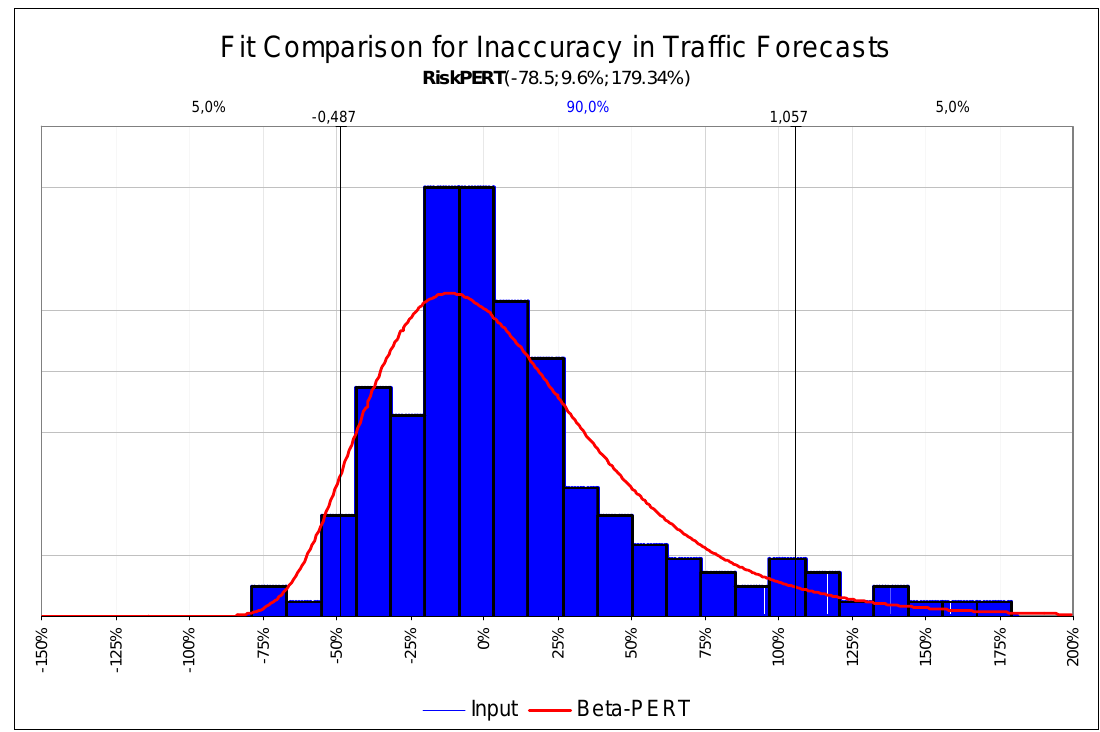
Figure 3. Inaccuracies of traffic forecasts in 183 road projects- calculated in percentage between ex-ante and ex-post analyses (adapted from Flyvbjerg et al. (2003), p.